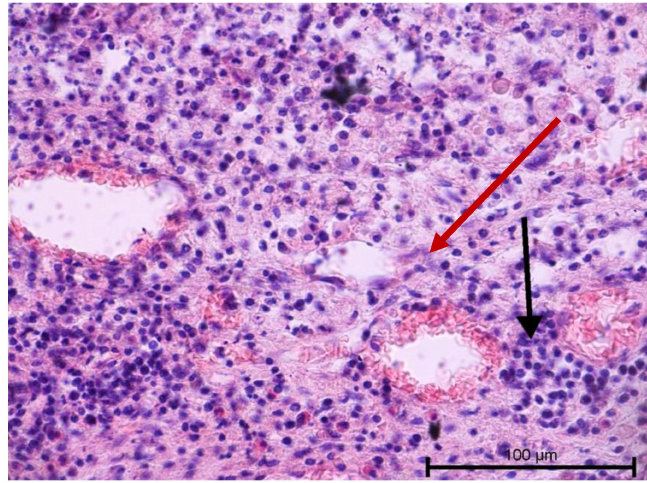
Figure 3. Light microscope image, human molar after extraction—Group III. Lymphocytice infiltra- tions (black arrow) and small capillary vessel (red arrow). Stain HE. Mag. 200 × .